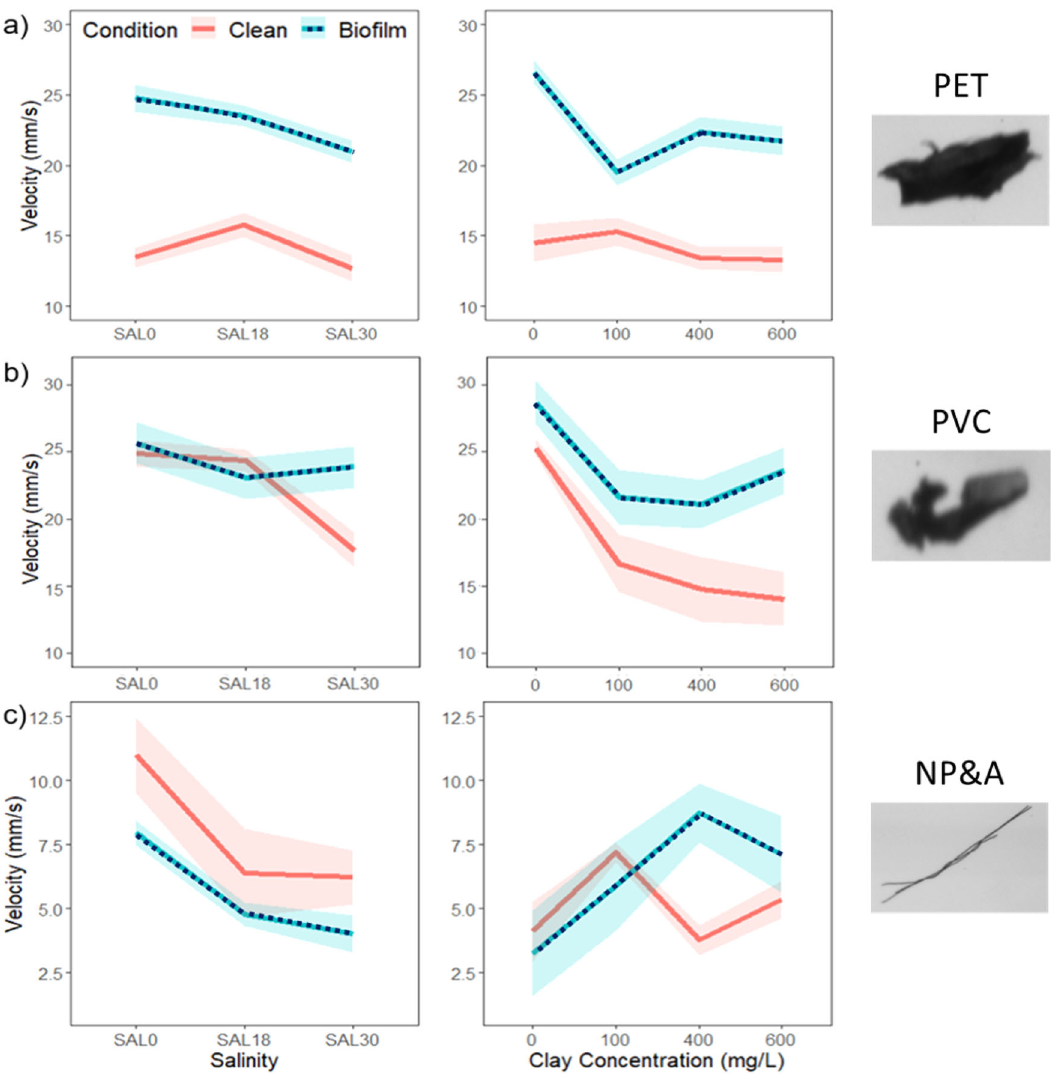
Fig. 2 Main effects plot of condition, salinity and clay concentration on non-buoyant microplastics. a Polyethylene terephthalate (PET), b polyvinyl chloride (PVC), and c nylon, polyester and acrylic (NP&A) fi bre microplastics. Solid lines indicate mean plots, while the shaded areas indicate con fi dence bands for all points. Red solid lines and shading are for clean particles, while blue dashed lines and shading are for bio fi lmed particles. For PET n = 1796, PVC n = 1015 and NP&A n = 1111. Note that for c the scale range is smaller as settling velocity was considerably lower for NP&A fi